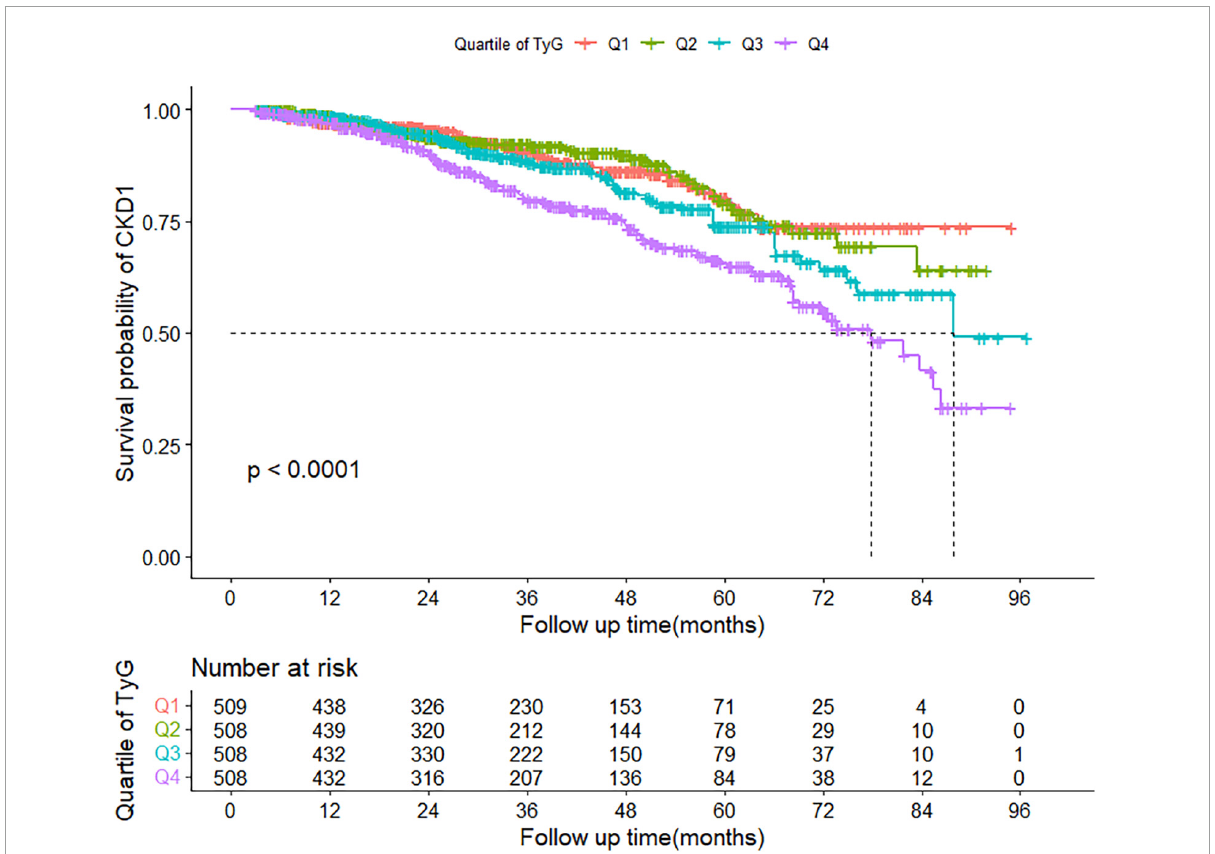
FIGURE2 Kaplan–Meier curve of cumulative incidence of CKD based on quartiles of TyG index; P -value was generated based on log-rank test. CKD, chronic kidney